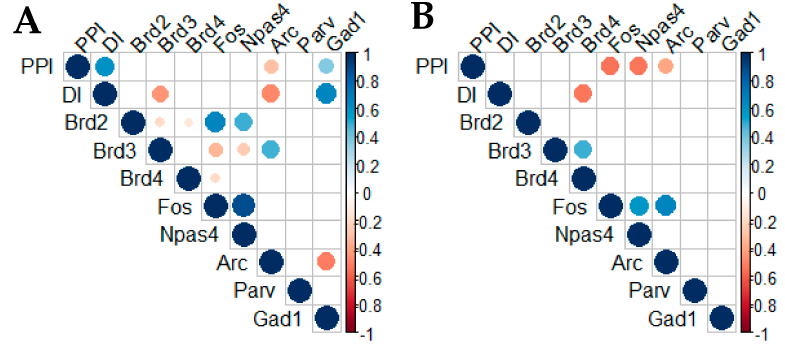
Figure 8. The matrix of correlation plots demonstrates correlations among the levels of the studied mRNA’s in the adult medial prefrontal cortex and behavioural data in males ( A ) and females ( B ) (Pearson’s correlation, p < 0.05). PPI—pre-pulse inhibition, DI—discrimination index. The colour code follows the indicated values of the correlation coefficient. The colour intensity and the size of the circles are proportional to the correlation coefficients. Two basic colours represent negative (red) or positive (blue) correlations.